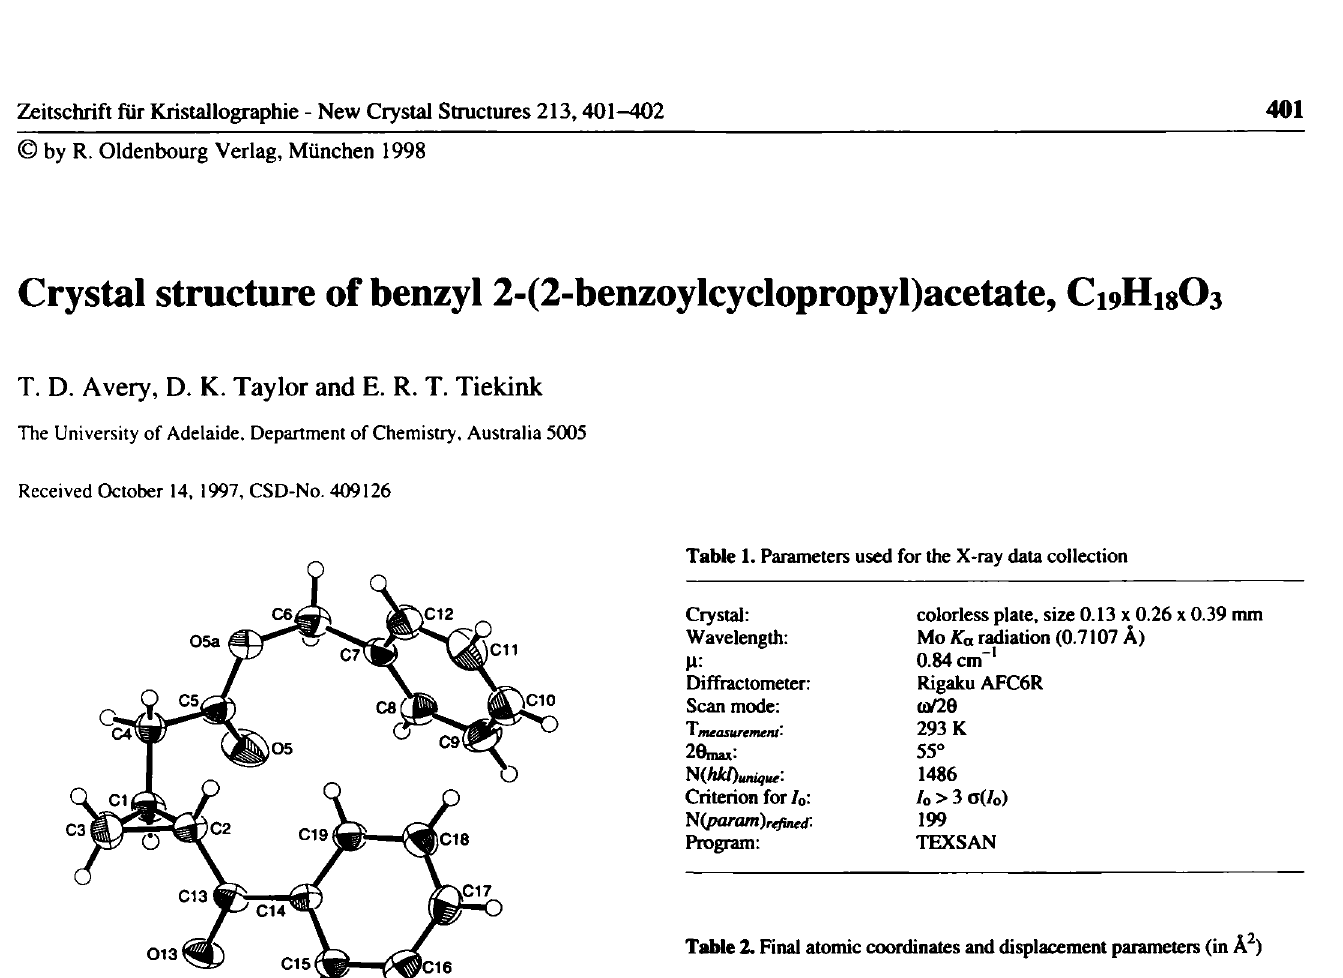
Table 2. Final atomic coordinates and displacement parameters (in